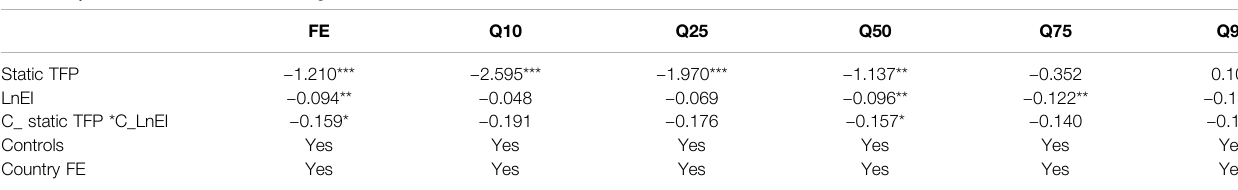
TABLE 7 | Robustness test for moderating effect.